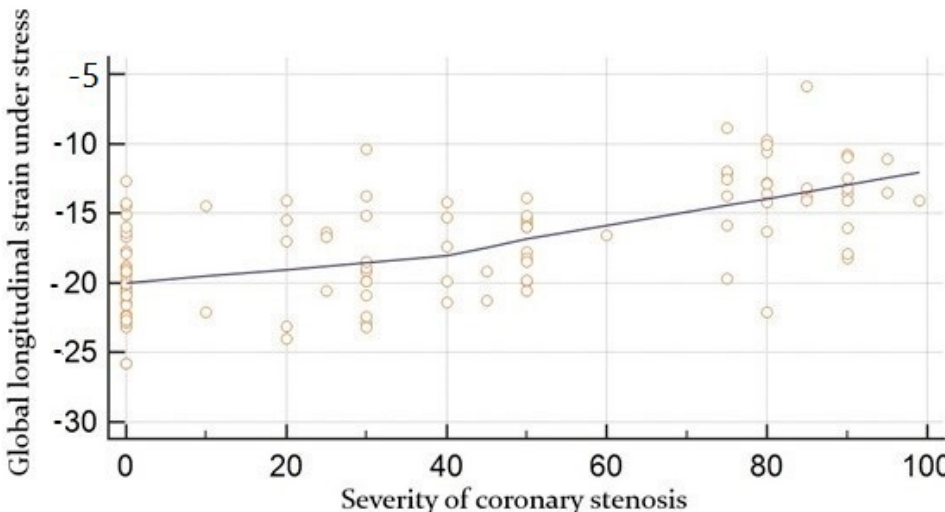
Figure 3. Correlation between global longitudinal strain at rest obtained by speckle tracking (in %) and the angiographic severity of coronary lesion (in %).